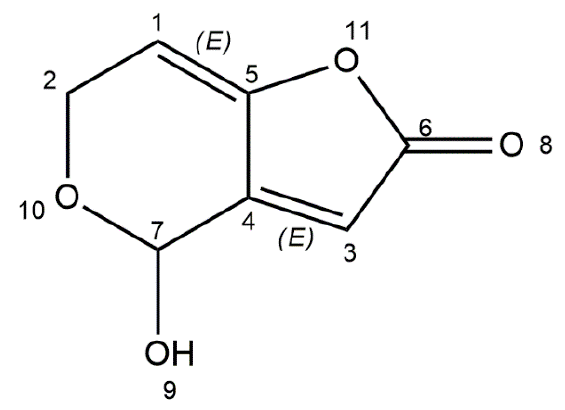
Figure 5. C hemical structure of patulin (structure generated from InChI code available on Figure 5. Chemical structure of patulin (structure generated from InChI code available on https: // pubchem.ncbi.nlm.nih.gov / ) (accessed on 16 August https://pubchem.ncbi.nlm.nih.gov/) (accessed on 16 August 2020).